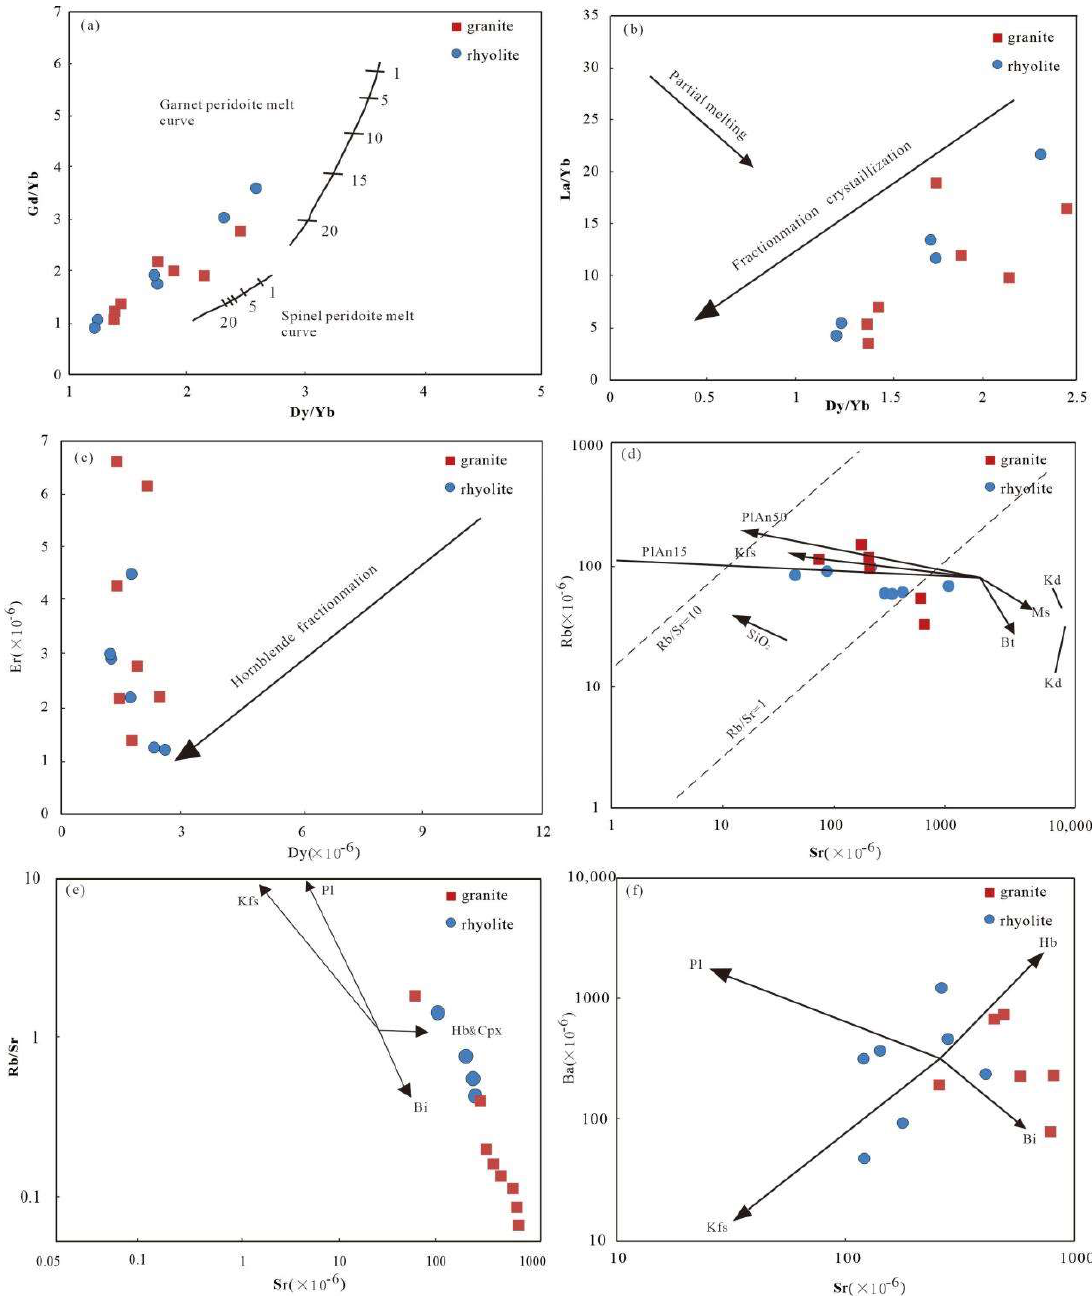
Figure 8. A fractional crystallization diagram of the Early Cretaceous magmatic rock from the Badaguan area. ( a ): Gd/Yb−Dy/Yb diagrams; ( b ): La/Yb−Dy/Yb diagrams; ( c ):Er−Dy diagrams; ( d ):Rb−Sr diagrams; ( e ):Rb/Sr−Sr diagrams; ( f ):Ba−Sr diagrams;.